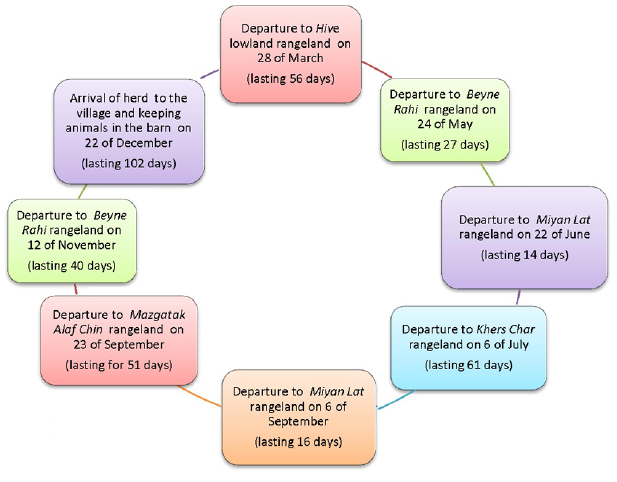
Fig. 4 . Herd management in the rangelands during 2011: herd no. 2.